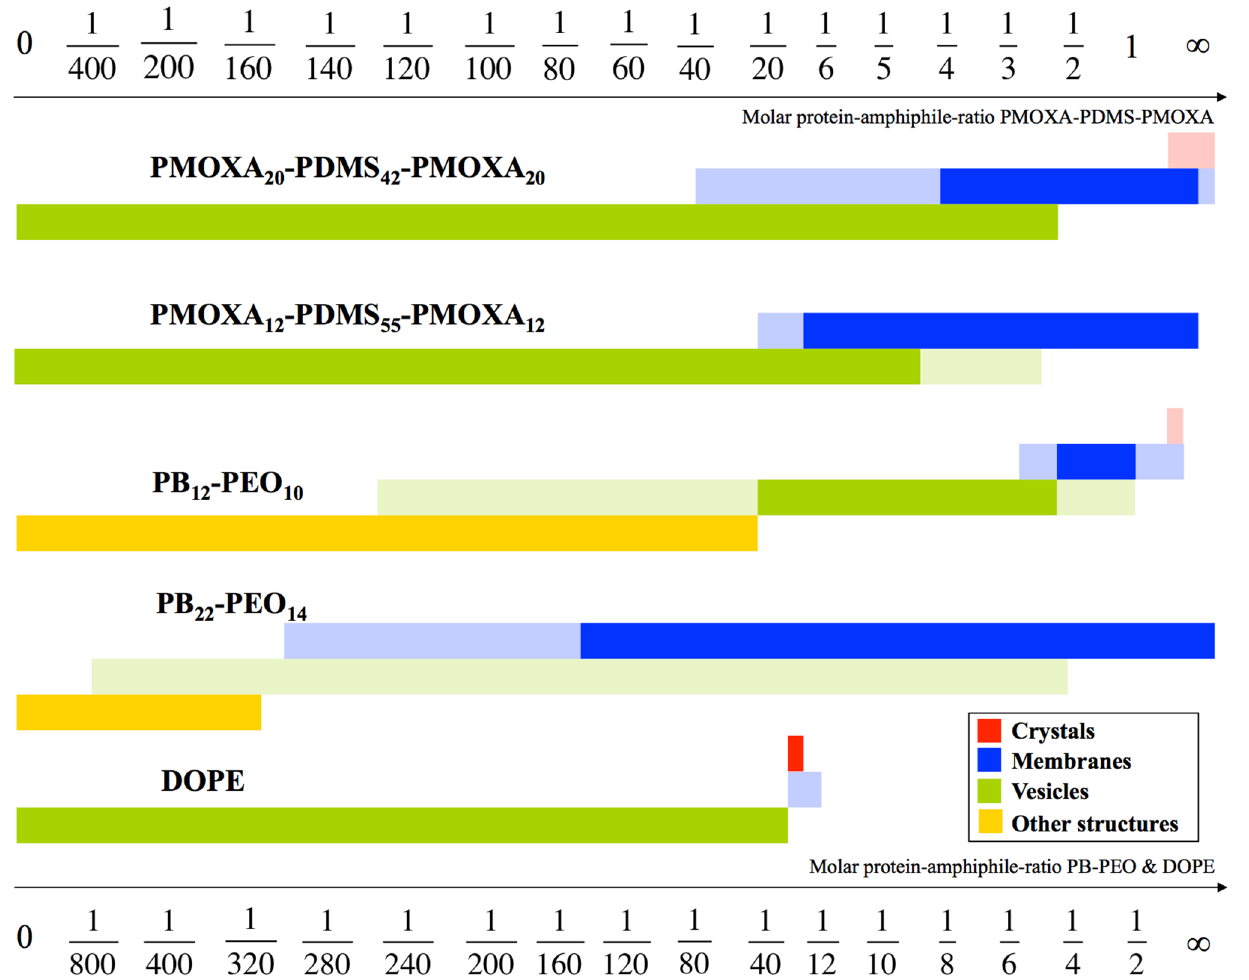
Figure 1. Schematic drawing of aggregate morphologies as a function of mPAR. PB 12 -PEO 10 undergoes four transitions. Surprisingly, the vesicle shape remained at significantly higher densities at block copolymers, compared to a standard lipid like 1,2-dioleoyl-sn-glycero-3-phosphoethanolamine (DOPE). The mPAR of the one-molecule- bilayer-forming ABA triblock copolymers was divided by two enabling direct comparison with the PB-PEO diblock copolymers and DOPE, both forming bilayers. The morphologies in full color are the main morphologies, pale colors denote coexisting morphologies. Adapted from